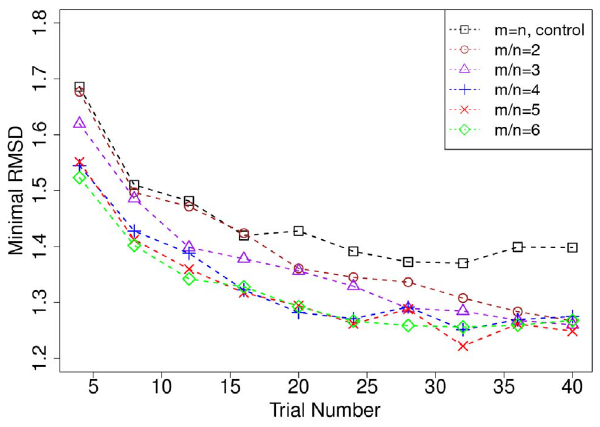
Figure 4. Mean of minimum backbone RMSD values for 140 protein loops. We generated 5,000 samples for each loop. The mean value of the minimum RMSD of the 140 loops ( y -axis) is plotted against the size of trial samples n ( x -axis) for different choices of m . For control, results obtained without sampling torsion angles ( m ~ n , control) are also plotted. The backbone (N, C a , C and O atoms) RMSD in this paper is calculated by fixing the rest of the protein body.